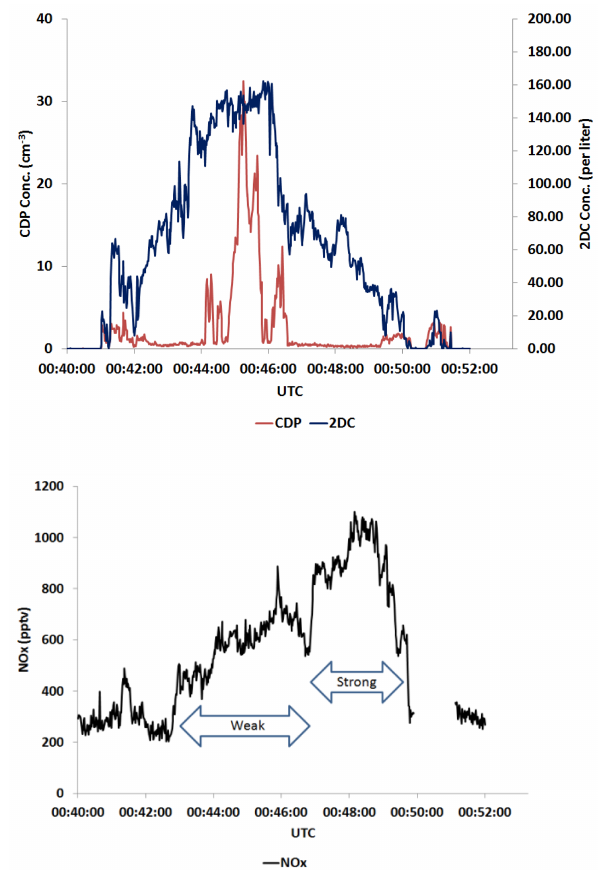
Figure 10. Concentrations from the CDP (red) and 2DC (blue) in- struments (top), and corresponding NO x concentrations (bottom) for a pass through the anvil of the 25/26 May 2012 case at an al- titude of 12.1km and temperatures of − 50.8 to − 54.2 ◦ C. Anvil regions downstream of the electrically weak and strong cells are indicated.